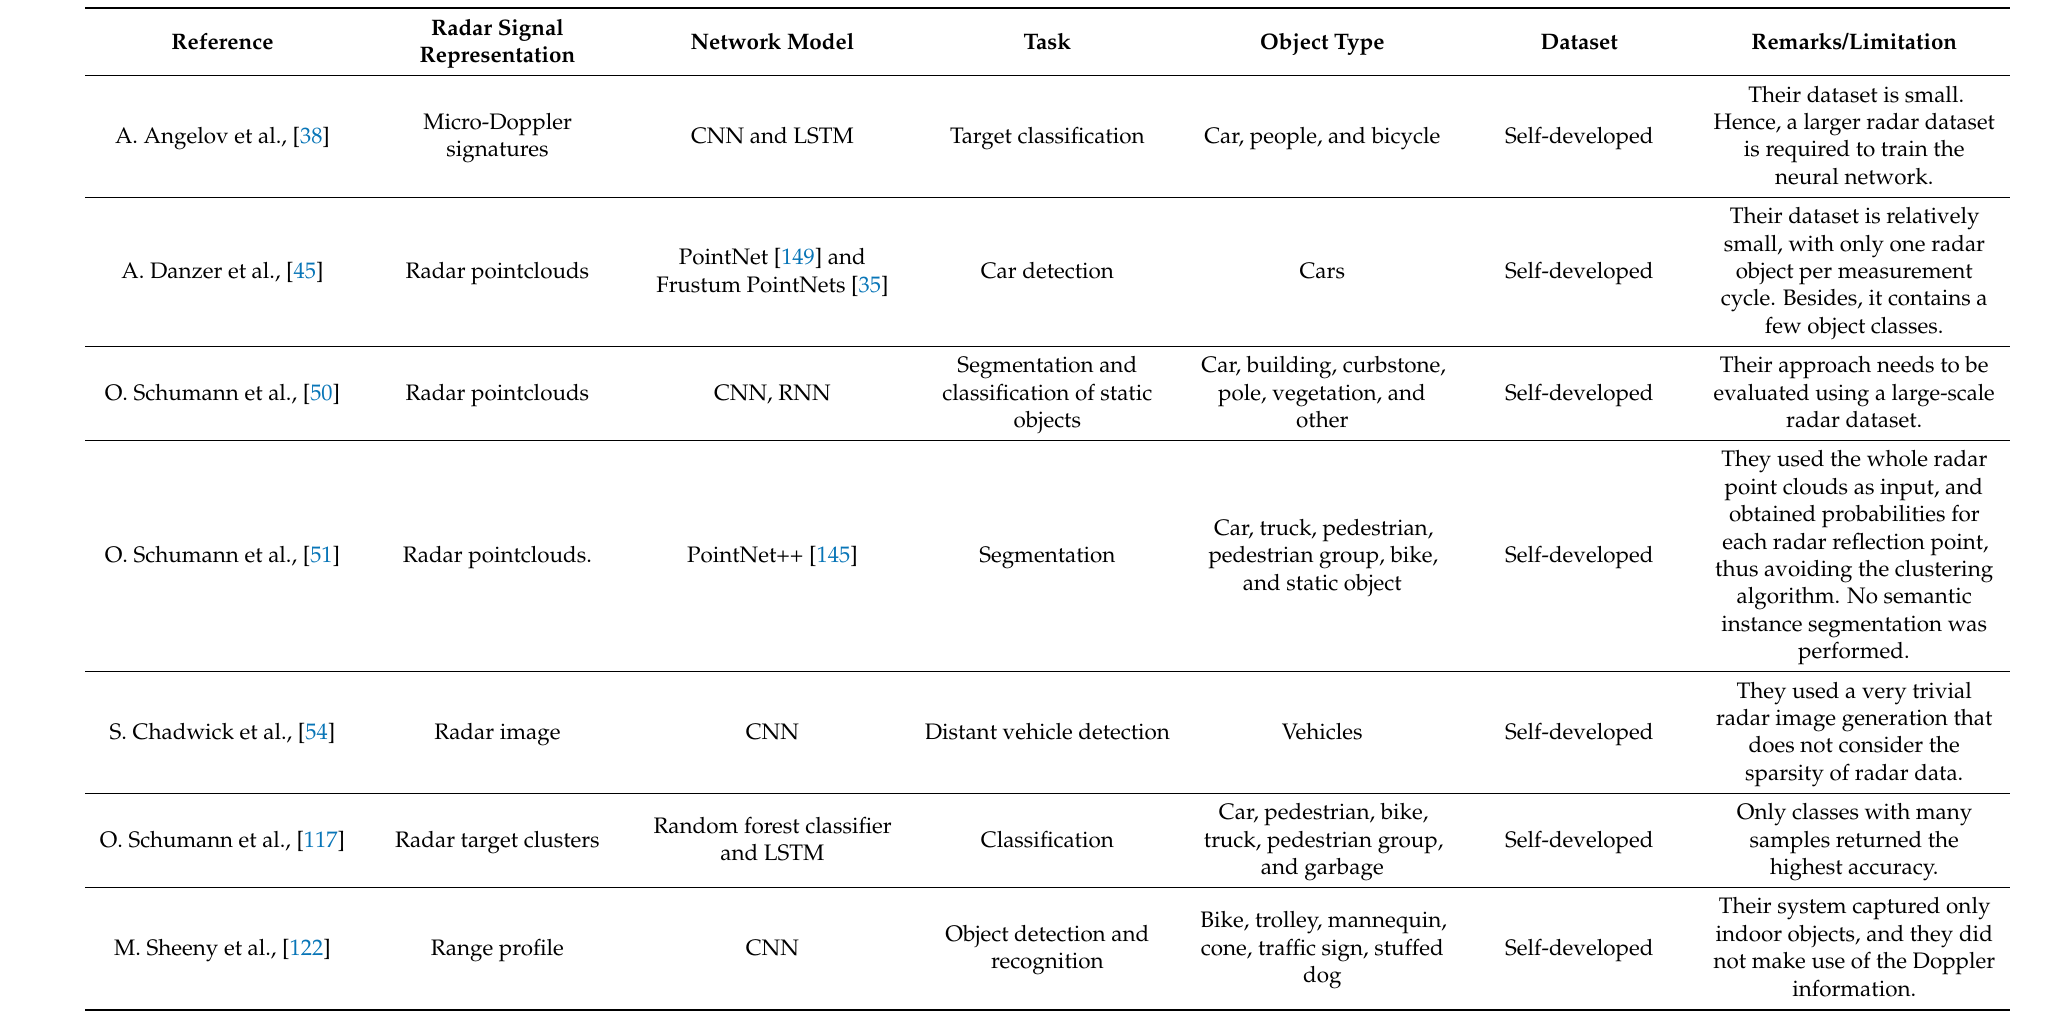
Table 1. Summary of the deep-learning algorithms using different radar signal